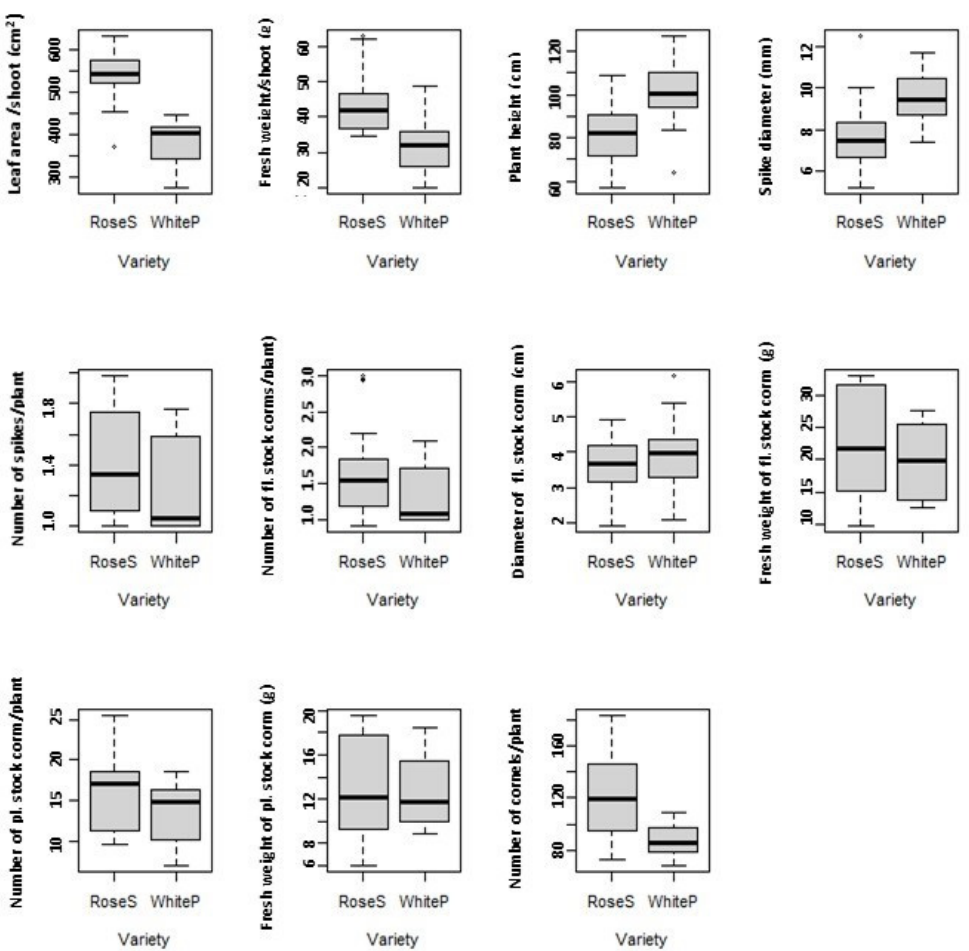
Figure 4. Effect of apical bud removal on the different corm and leaf variables illustrated as boxplots where the boxes define a lower and an upper percentile, in which 75% of the observations are found, and the marked line defines the median value of a given